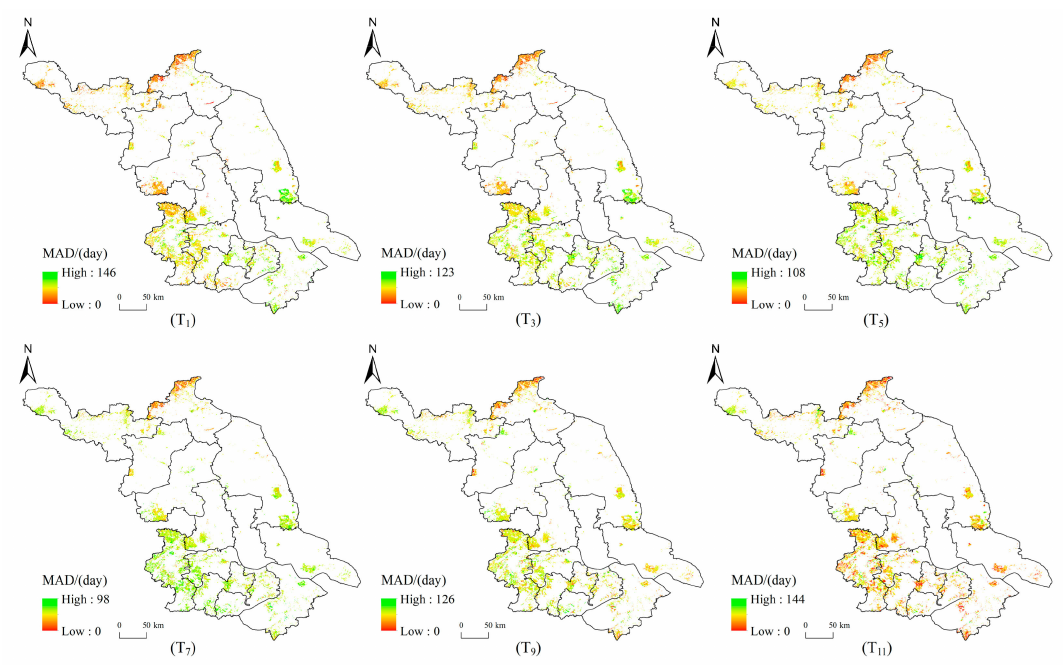
Figure 4. Spatial distribution of the MAD of single cropping system. Partial results (T 1 , T 3 , T 5 , T 7 , T 9 , and T 11 ) are shown. T 1 : 2001–2007; T 2 : 2002–2008; T 3 : 2003–2009; ... ; T 11 :